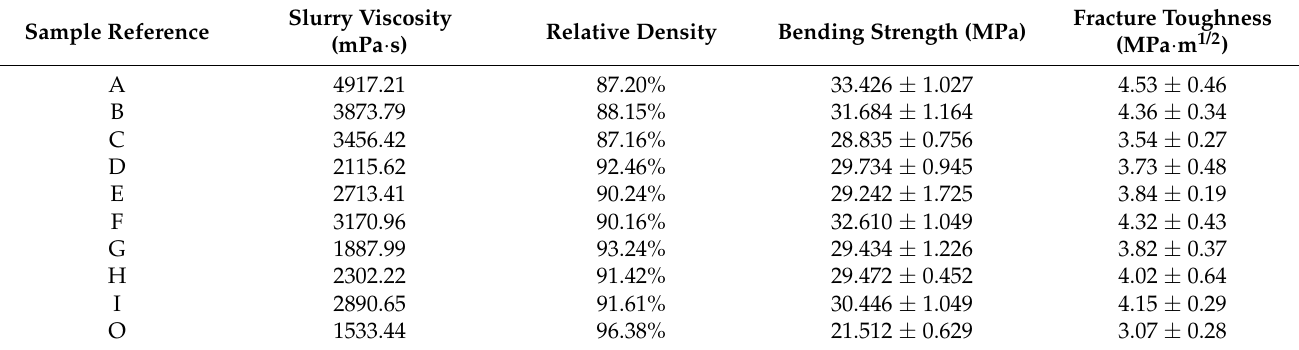
Table 2. At a sintering temperature of 1500 ◦ C, the mechanical properties of 3D-printed alumina ceramics reinforced with different components of short carbon fiber were compared, and group O is